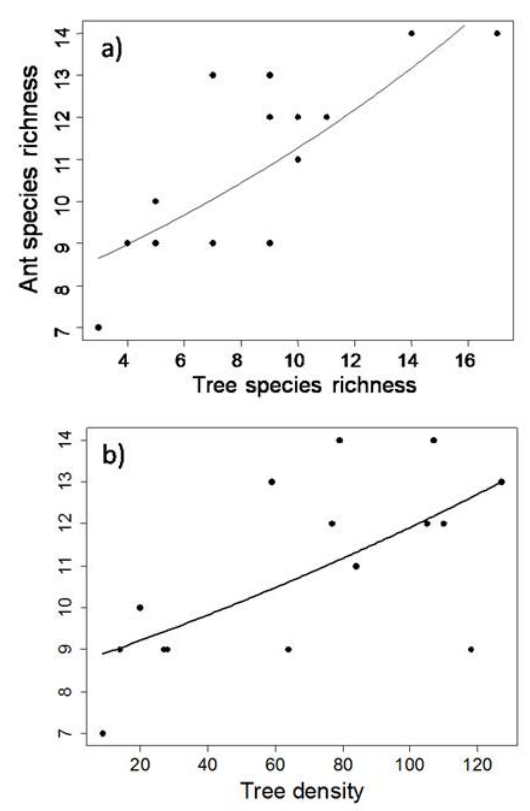
Fig 2 . Species richness of arboreal ants in response to (a) tree species richness and (b) tree density among 15 plots in fragments of